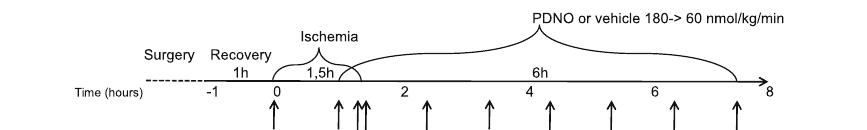
Fig. 1 Schematic diagram illustrating the experimental protocol. After surgery, the sheep recovered for 60 min. Renal ischemia was caused by clamping of the left renal artery for 90 min. Fifteen minutes prior to the release of the clamp, intravenous infusions of either the organic mononitrites of 1,2-propanediol (PDNO) or vehicle (1,2-propanediol + inorganic nitrite) were commenced. The infusions continued for 6 h, during which renal function was monitored. The arrows indicate times for measurements and blood-/urine-sampling performed at baseline, prior to treatment, prior and directly following the release of the clamp, and continuously every hour after treatment was